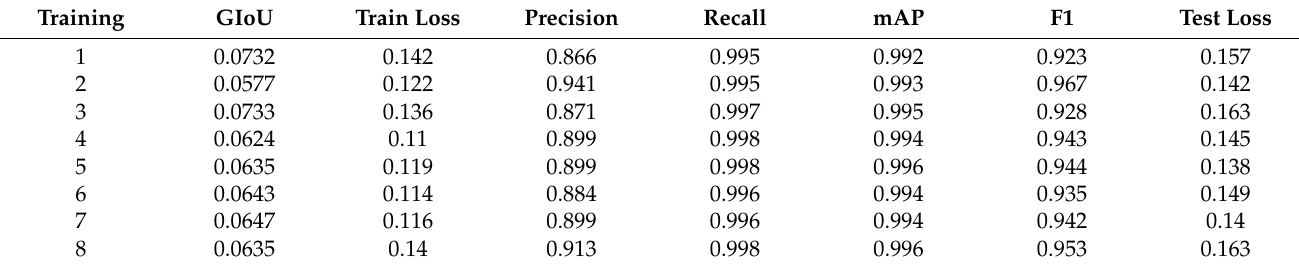
Table 3. Summarized training